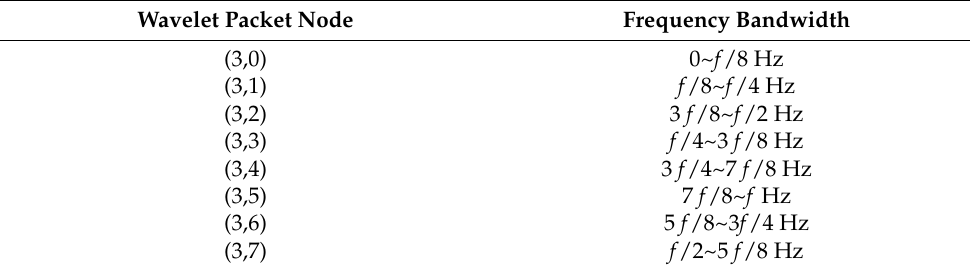
Table 2. Frequency bandwidth and corresponding